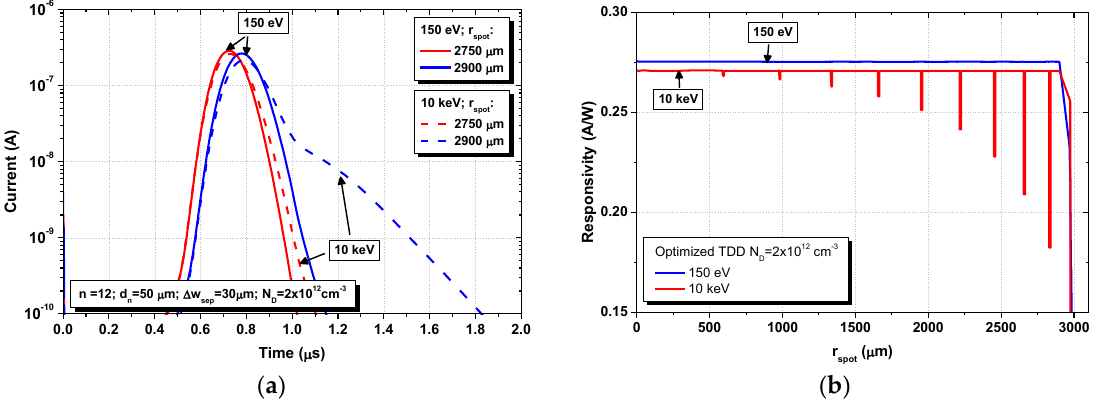
Figure 8. ( a ) Transient responses of a TDD structure to 150-eV and 10-keV light energy spots impinging at different positions r spot on the photodiode; ( b ) Steady-state responsivity to 150-eV and 10-keV light energy spots as a function r spot for a TDD with N D = 2 × 10 12 cm −3 .